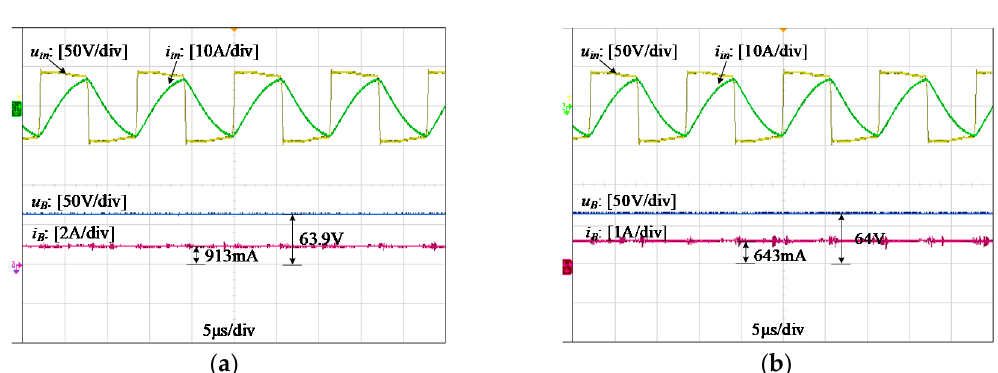
Figure 15. Experimental waveforms of u in , i in in CV mode when ( a ) R B = 70 Ω and ( b ) R B = 100 Ω .